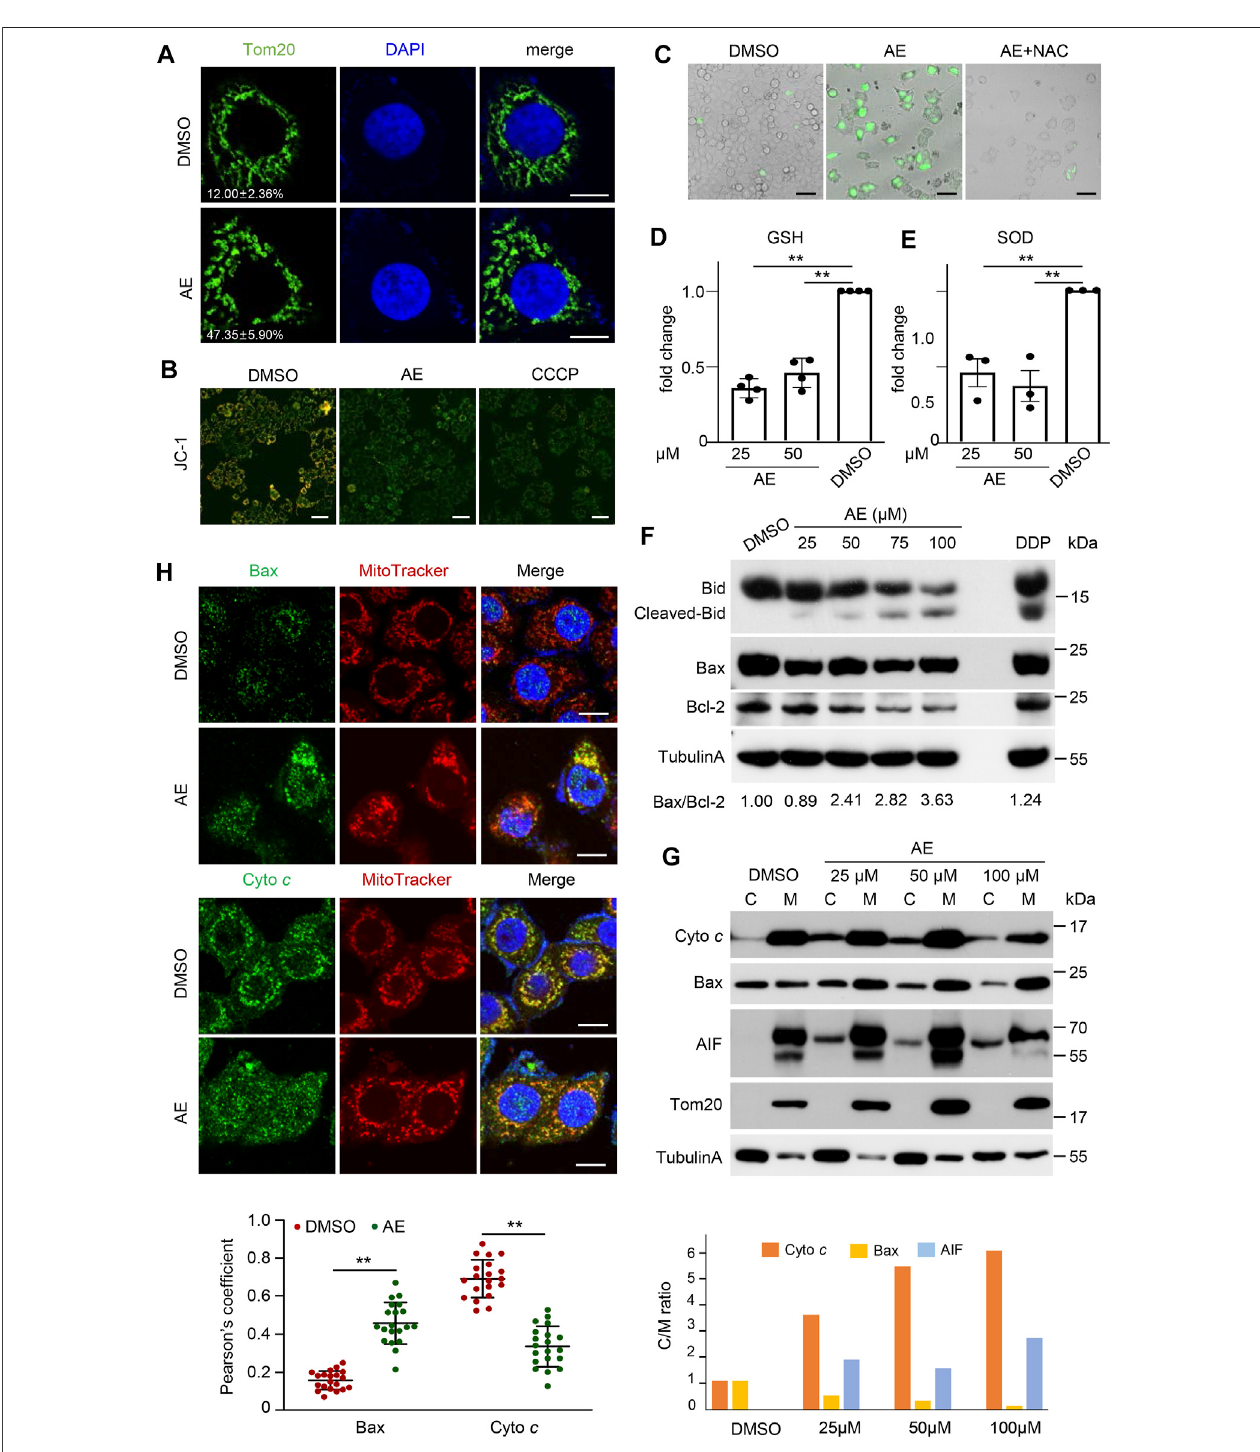
FIGURE 5 | AE induces mitochondrial dysfunction of HeLa cells. (A) Effects of AE on the mitochondrial morphology. HeLa cells were treated with AE (50 μ M) for 24 h.FluorescencedetectionofTom20(green)andDAPI(blue)areshown.Statisticsofcellsshowingobviousmitochondrialministacksarelistedinthelower-leftcorner. At least 100 cells were counted for each group, and the statistical data shown are from three independent determinations. Scale bar, 10 μ m. (B) Effects of AE on the mitochondrial membrane potential. The mitochondrial membrane potential was determined by the JC-1 assay. The merged fl uorescence detections of JC-1 aggregates(red)andJC-1monomer(green)areshown.ColorchangefromorangetogreenindicatedthattheJC-1changedfromaggregatestomonomers,andthatthe mitochondrial membrane potential changed from ahigh level to a lowlevel. Scale bar, 100 μ m. (C – E) Effects ofAE on the mitochondrialoxidativestress. HeLacells were